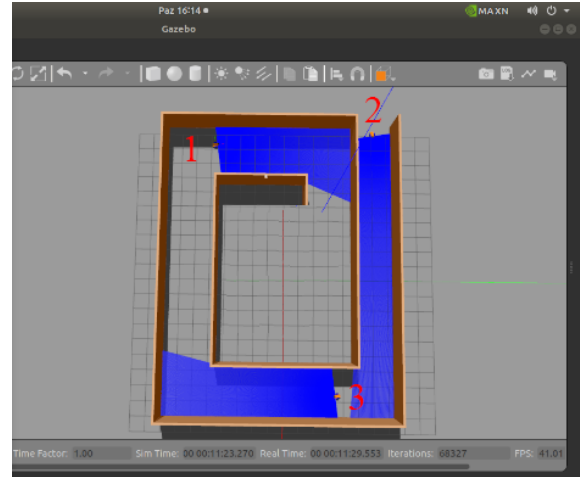
Figure 8. Environment and Motion Images for Simulation